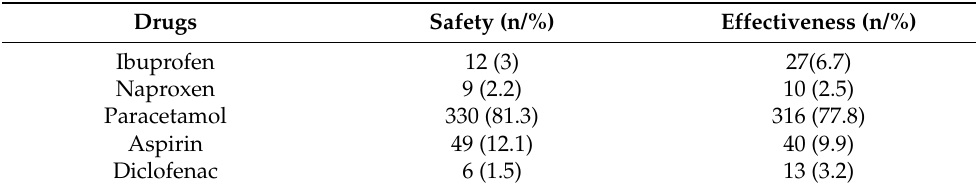
Figure 1. Are any of the following drugs considered non-steroidal anti-inflammatory drugs? Table 3. Safety and effectiveness of analgesic during pregnancy.